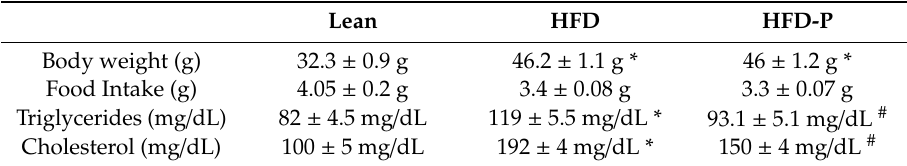
Body weight, food intake, triglyceride and cholesterol plasma concentrations of lean, HFD, and HFD